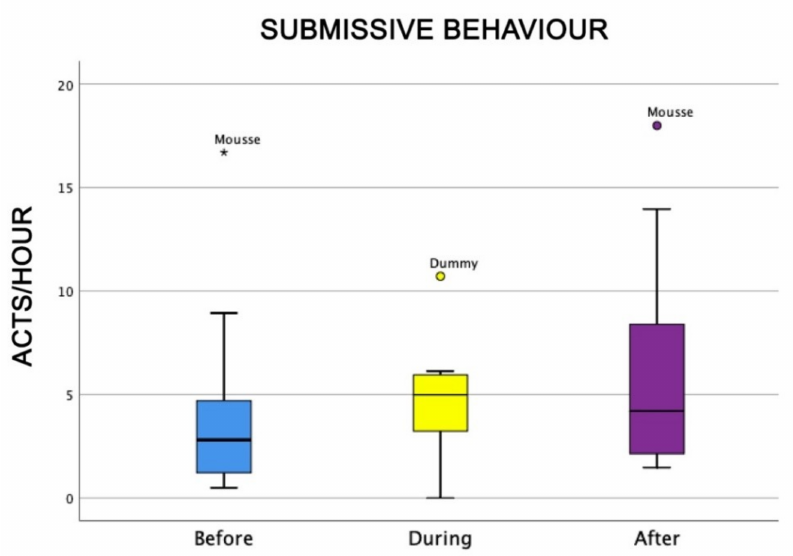
Figure 3. Behavioural patterns related to dogs’ submissive behaviour before, during, and after AAI sessions. Non-parametric data are represented as medians (horizontal bar in the box) and the box indicates the interquartile range of 50% of the data. Whiskers extend to the smallest and largest values and exclude outliers (dot on top).